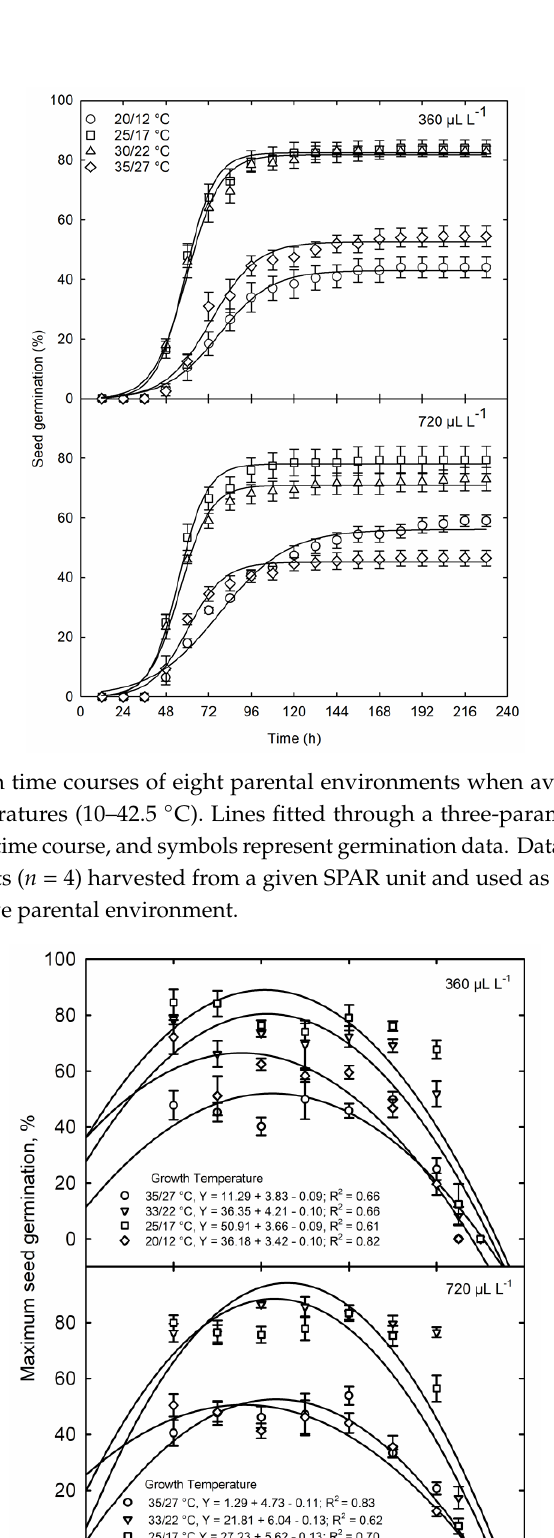
Figure 1. Big bluestem seed germination time course obtained from plants grown under two parental environments representing 30/22 °C day/night temperatures under ( A ) 360-µL L −1 and ( B ) 720-µL L −1 CO 2 concentrations. Data are means ± standard error (SE) of four plants ( n = 4) harvested from a given SPAR unit and used as replicates in statistical analysis for a respective parental environment.